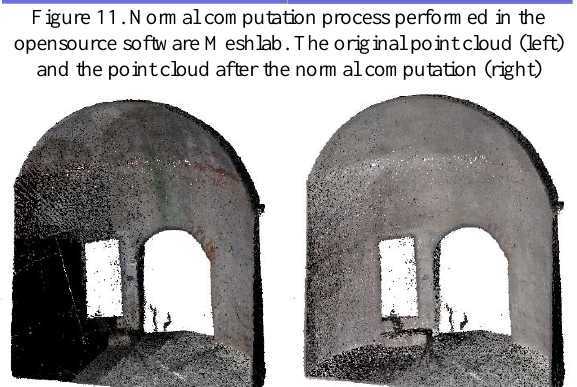
WITH correct normal